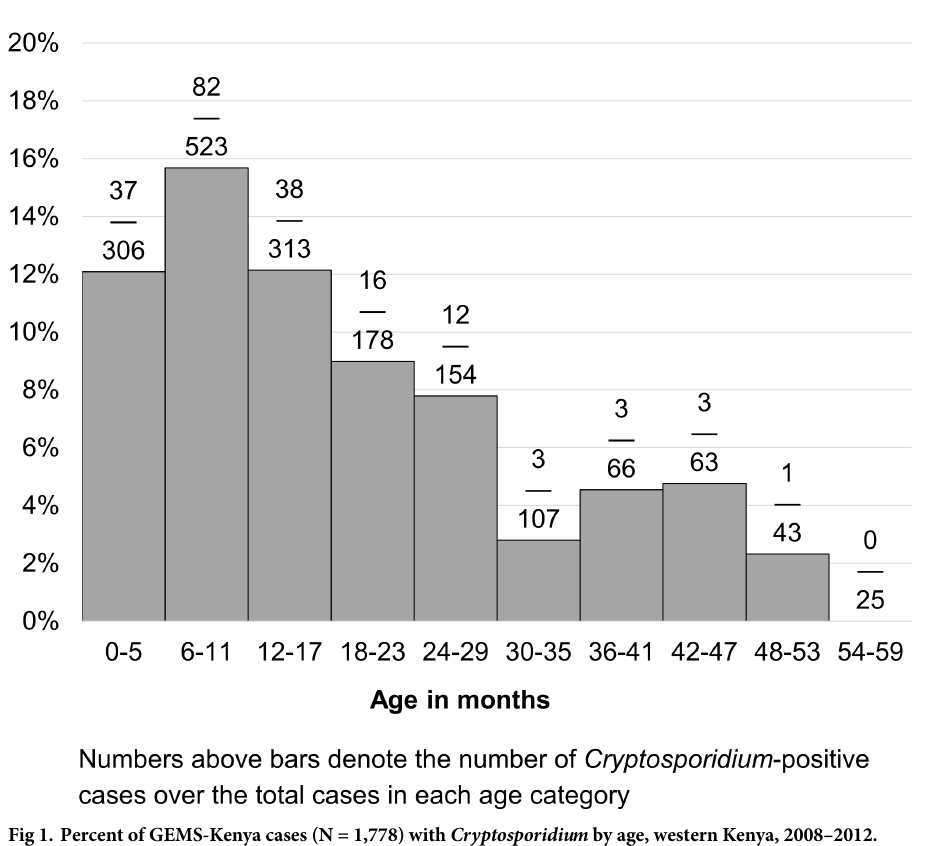
Fig 1. Percent of GEMS-Kenya cases (N = 1,778) with Cryptosporidium by age, western Kenya,